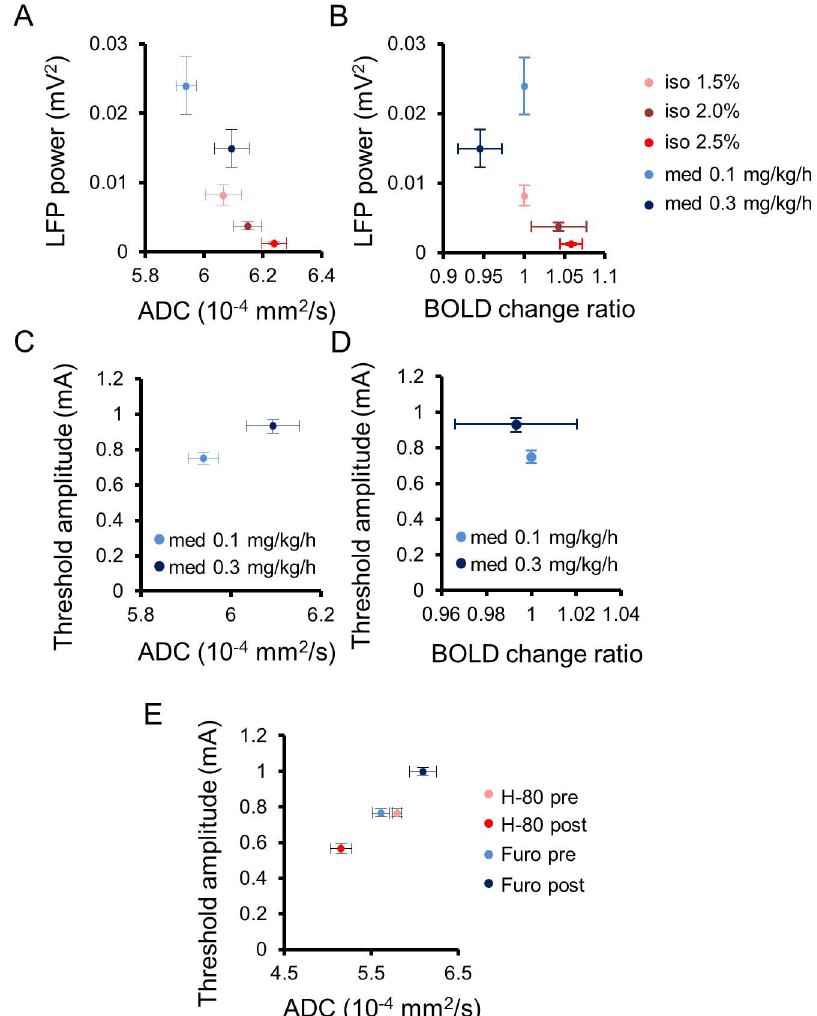
Fig 7. Summarized relationship of the Apparent Diffusion Coefficient (ADC) with underlying neural activity status in the Central Medial thalamic nucleus (CM). Scatter plots between local field potential (LFP) power and ADC (A) or blood oxygenation level—dependent(BOLD) changeratio (B) in the CM under all anestheticconditions (isoflurane:1.5%, 2.0%, and 2.5%; medetomidine: 0.1 and 0.3 mg/kg/h). Scatter plots of CM ADC (C) and CM BOLD change ratio (D) with the threshold amplitudeto trigger an awake responseduringCM electrical stimulation under anesthesiawith 0.1 and 0.3 mg/kg/h of medetomidine. (E) Scatter plots betweenCM ADC and the thresholdamplitudeto trigger an awake response under anesthesia (0.1 mg/kg/h medetomidine) before and after CM infusion of furosemide and H-80. Data with anesthetic dosagesfor the CM of individual rats can be found in S1 Data for ADC and S2 Data for BOLD. LFP power data with anestheticdosagesfor CM of individual rats can be found in S4 Data. Data for minimum amplitudes of individual rats can be found in S5 Data. ADC data for pharmacologicaldiffusionfunctionalMRI (DfMRI) of individual rats found in S3 Data.